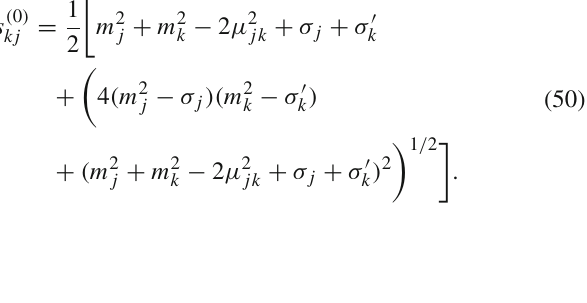
Fig. 11 Motion of s ( ± ) in the s -plane as a function of σ (cid:6) for fixed 13 1 σ = 4 . 41, and unit external masses, m = m = m = 1. Shown in 3 1 2 3 ( + ) ( − ) red is s and in blue s . The points indicate various σ (cid:6) values. Note 13 13 1 = 4. The inset shows the infinitesi- that the physical region begins at σ (cid:6) 1